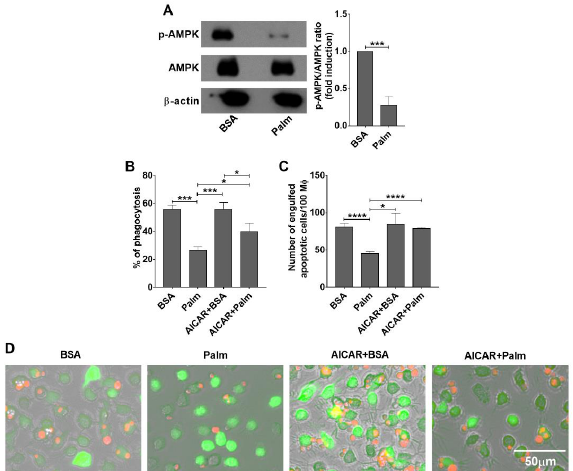
Figure 2. Exposure of BMDMs to palmitate results in a decrease in AMPK activity leading to inhibition of efferocytosis. ( A ) Exposure to 0.4 mM palmitate for 24 h leads to a decreased Thr 172 phosphorylation of AMPK in BMDMs detected by Western blot analysis. β -actin was used as a loading control. One representative gel of three is shown. AICAR (0.5 mM), an AMPK activator, attenuates the efferocytosis inhibition of BMDMs induced by palmitate (0.4 mM) exposure for 24 h detected by ( B ) determining the percentage of engulfing macrophages by FACS analysis or by ( C ) counting the number of engulfed cells. All data are expressed as mean ± SD ( n = 4). Asterisks indicate statistically significant difference (* p < 0.05, *** p < 0.001, and **** p < 0.0001). ( D ) Representative fluorescent microscopic images of macrophages (green) engulfing apoptotic thymocytes (red) following 40 min of efferocytosis in the presence or absence of 0.4 mM palmitate with or without AICAR.